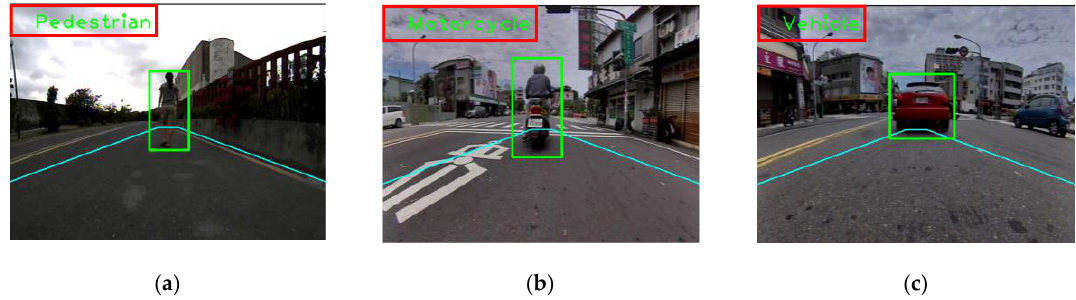
Figure 7. Classification results of vision-based recognition: ( a ) pedestrian, ( b ) motorcycle, and ( c ) car.